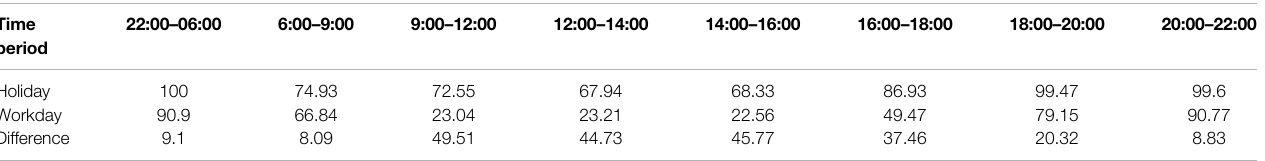
TABLE 4 | Proportions (%) of household members in buildings in Luomo Village on different days. Time